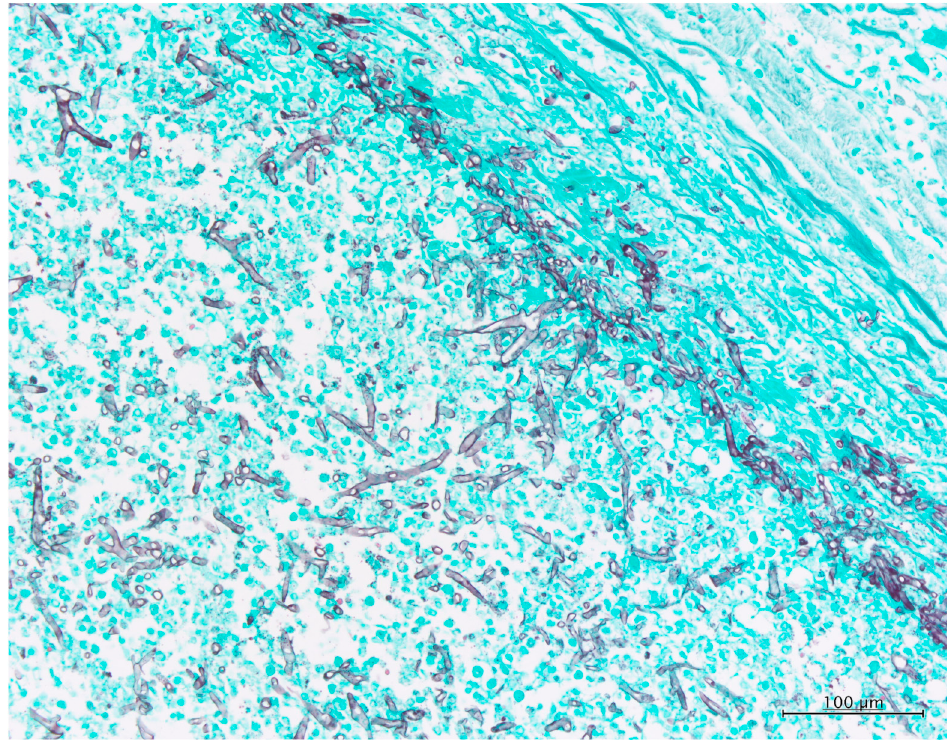
Figure 2. Histopathology findings of the autopsy case of the lung. Grocott’s stain (×200). Many hyphae in the lumen of the pulmonary artery have a thin and folded wall and show bifurcation with irregular angle, but rectangular bifurcation is occasionally noted. Septae are rarely found.